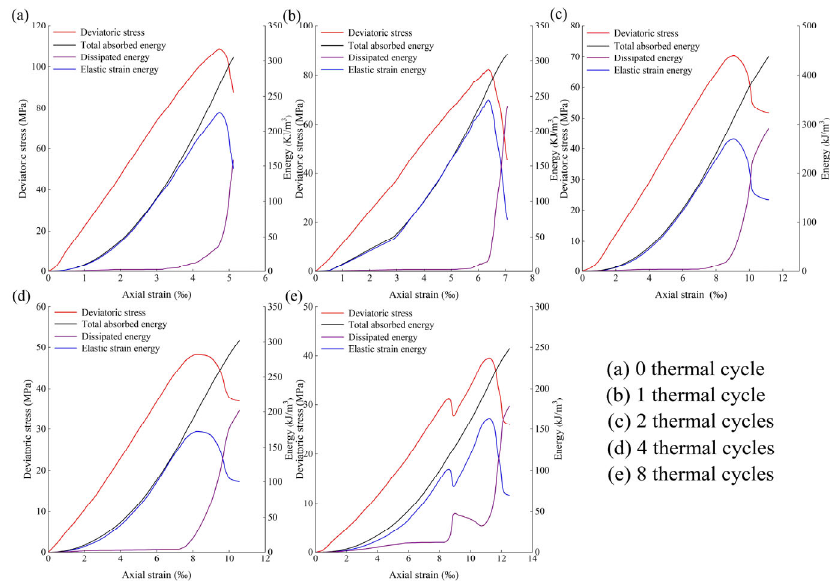
Figure 12. Energy evolution law under different numbers of thermal cycles. For the post ‐ peak stage, U e decreased sharply and U d increased greatly. There was a peak value in both energy curves. The value of U e corresponds to peak stress of axial stress ‐ strain curve, and U d increases gradually with axial strain. Therefore, the peak point of U d corresponds to the maximum axial strain, and U e in this stage will be converted into energy dissipation and release.